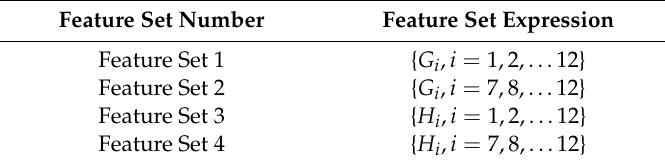
Table 2. Feature set definition.